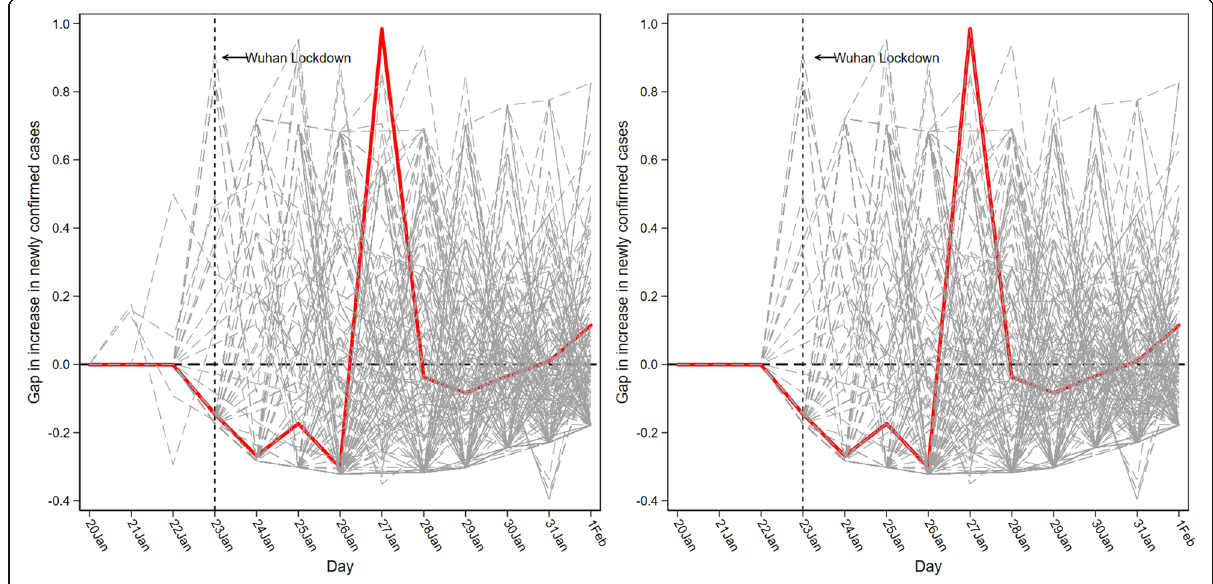
Fig. 6 NewGrowth gaps in Wuhan and placebo gaps in 278 control